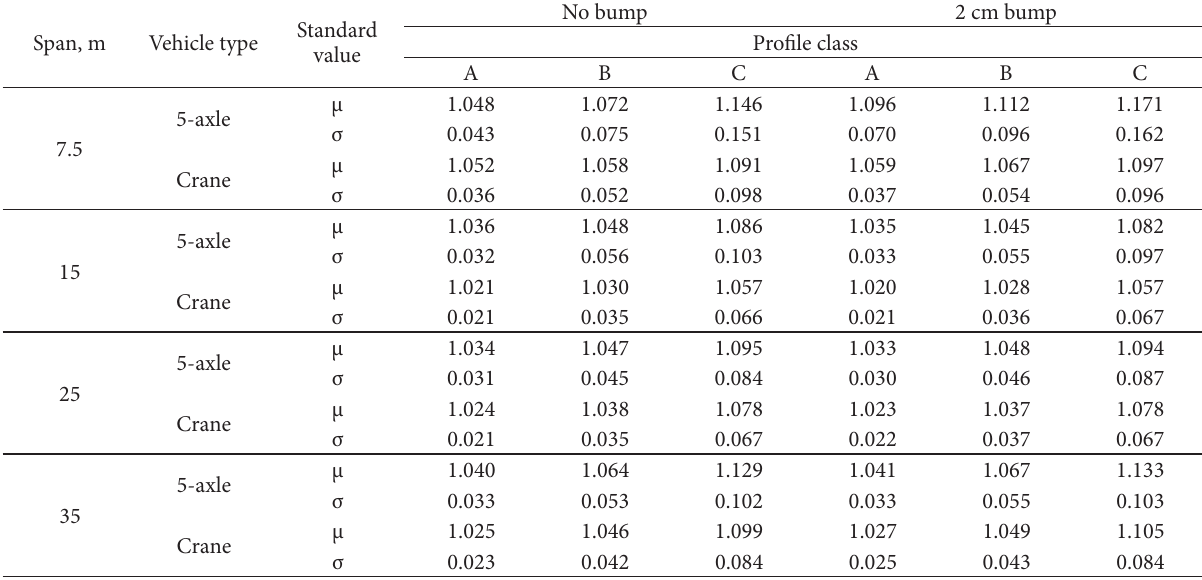
Table 5. Mean (μ) and standard deviation (σ) for DAF results from Monte Carlo simulation of single vehicle events Span, m